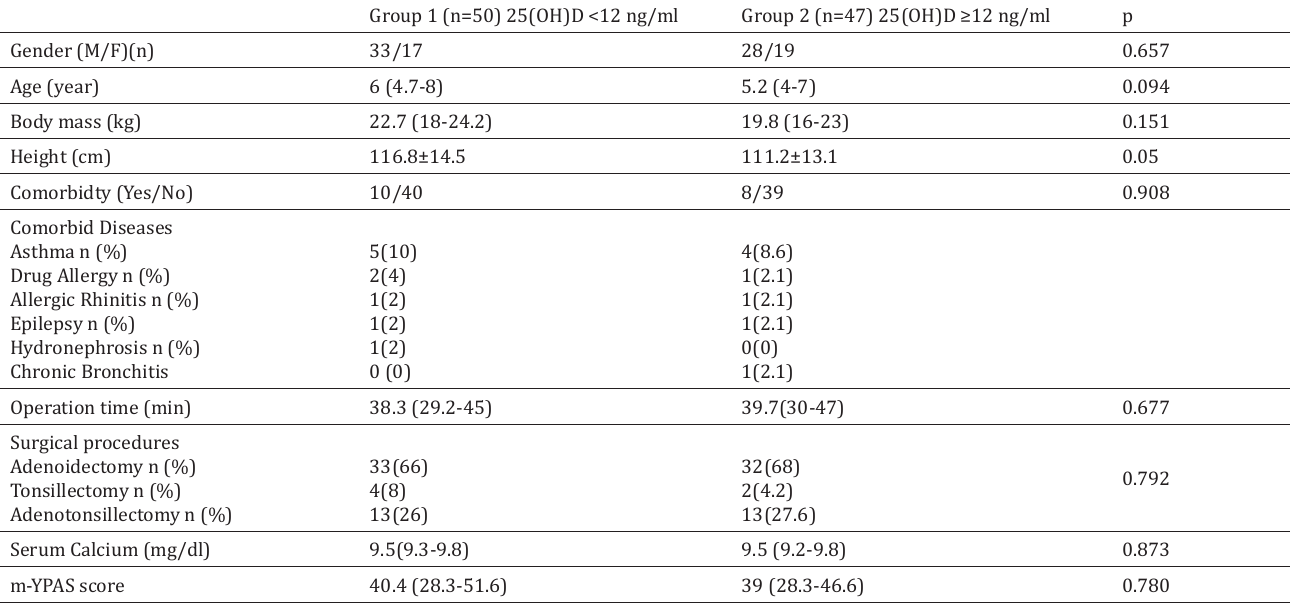
Distribution of the demographic, clinical, and laboratory characteristics by the patient groups